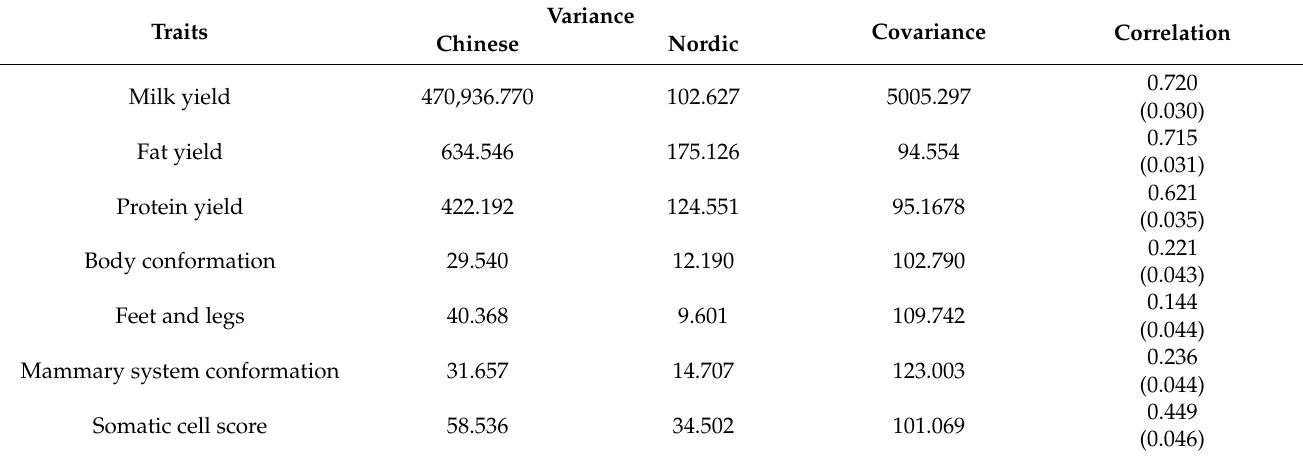
Table 2. Genetic correlation of traits between Chinese and Nordic Holstein